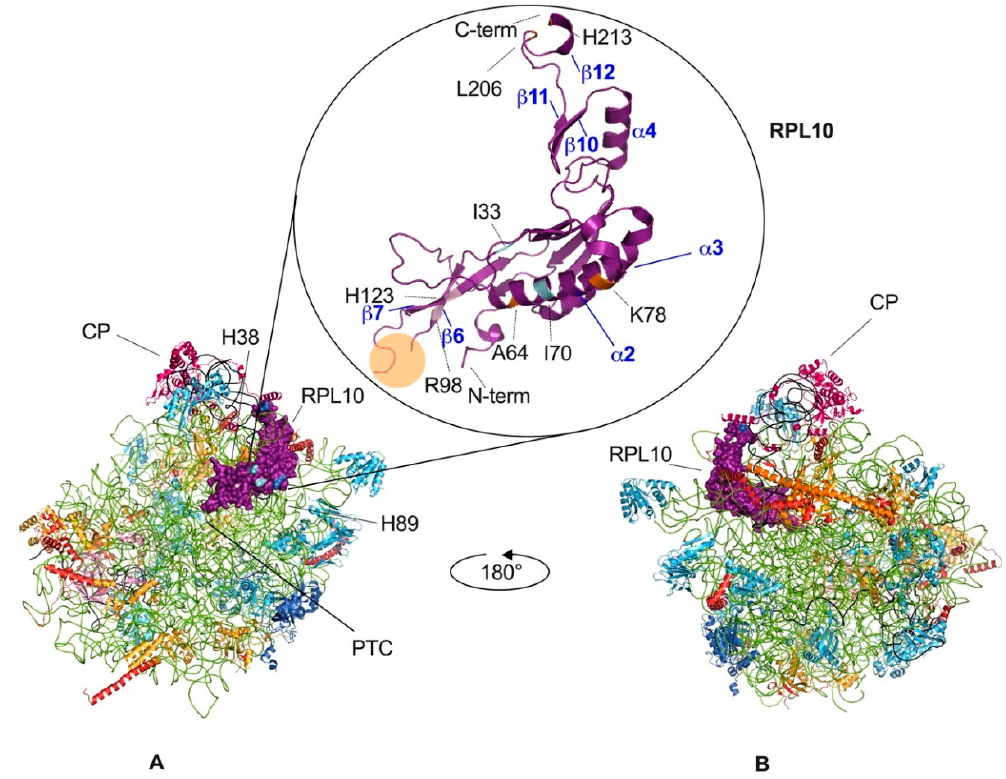
Figure 2. Eukaryotic large ribosomal subunit and RPL10 mutations. Tetrahymena termophila 60S subunit, views of the 40S-exposed ( A ) and solvent-exposed ( B ) sides. RPL10 is in purple, 25S rRNA is in green, 5S is rRNA in black, and 5.8S is in carbon (visible in panel B). The localization of the central protuberance (CP), of the peptidyl-transferase center (PTC) and of other elements, which are significant for the present review are pinpointed in the 40S-exposed view. In the circle, the structure of the RPL10 protein is magnified, while clinically significant mutations are highlighted in different colors (pale pink for the mutations involved in T-ALL, light blue for the mutations involved in multiple myeloma, orange for the mutations involved in CNS-related abnormalities). The P-loop (between residues 102 and 112, orange circle) cannot be visualized because no ligand is present in this structure, as also explained in the main text. Some of the α helices and β sheets have been labeled, according to the numbering in Figure 1. The figure was generated using PyMOL (Schrodinger, LLC).